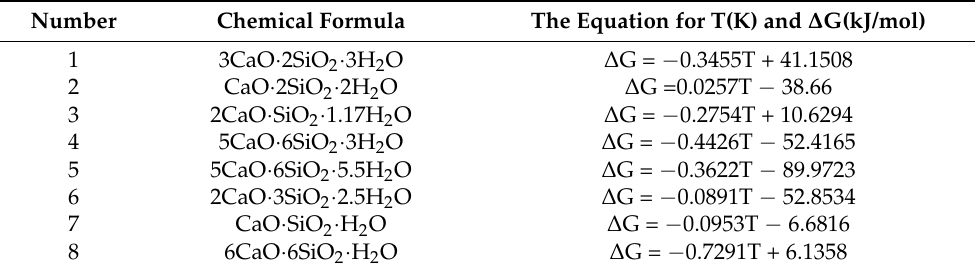
Table 5. The thermodynamic equations of various calcium silicates.